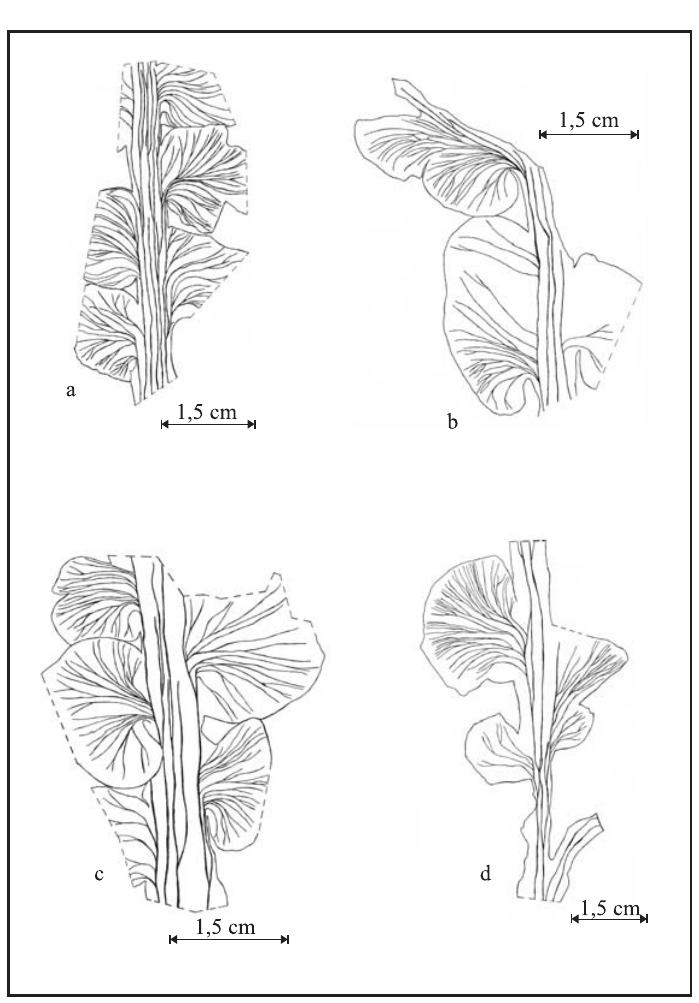
Fig. 4 – Botrychiopsis valida fronds from Quitéria. (a) middle portion of a frond with pines, showing the venation of the rachis, the insertion of the pines in the rachis and is venation – PbU 0281; (b) middle portion of the frond with complete limbus presenting small insertions and the venation of the rachis and pines – PbU 0233; (c) basal portion of the frond with the insertion of the pines and venation – PbU 0252; (d) basal portion of the frond with the insertion of the pines and venation – PbU